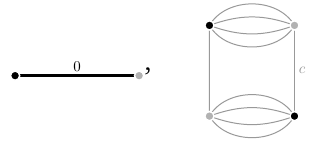
Figure 2: Coloured